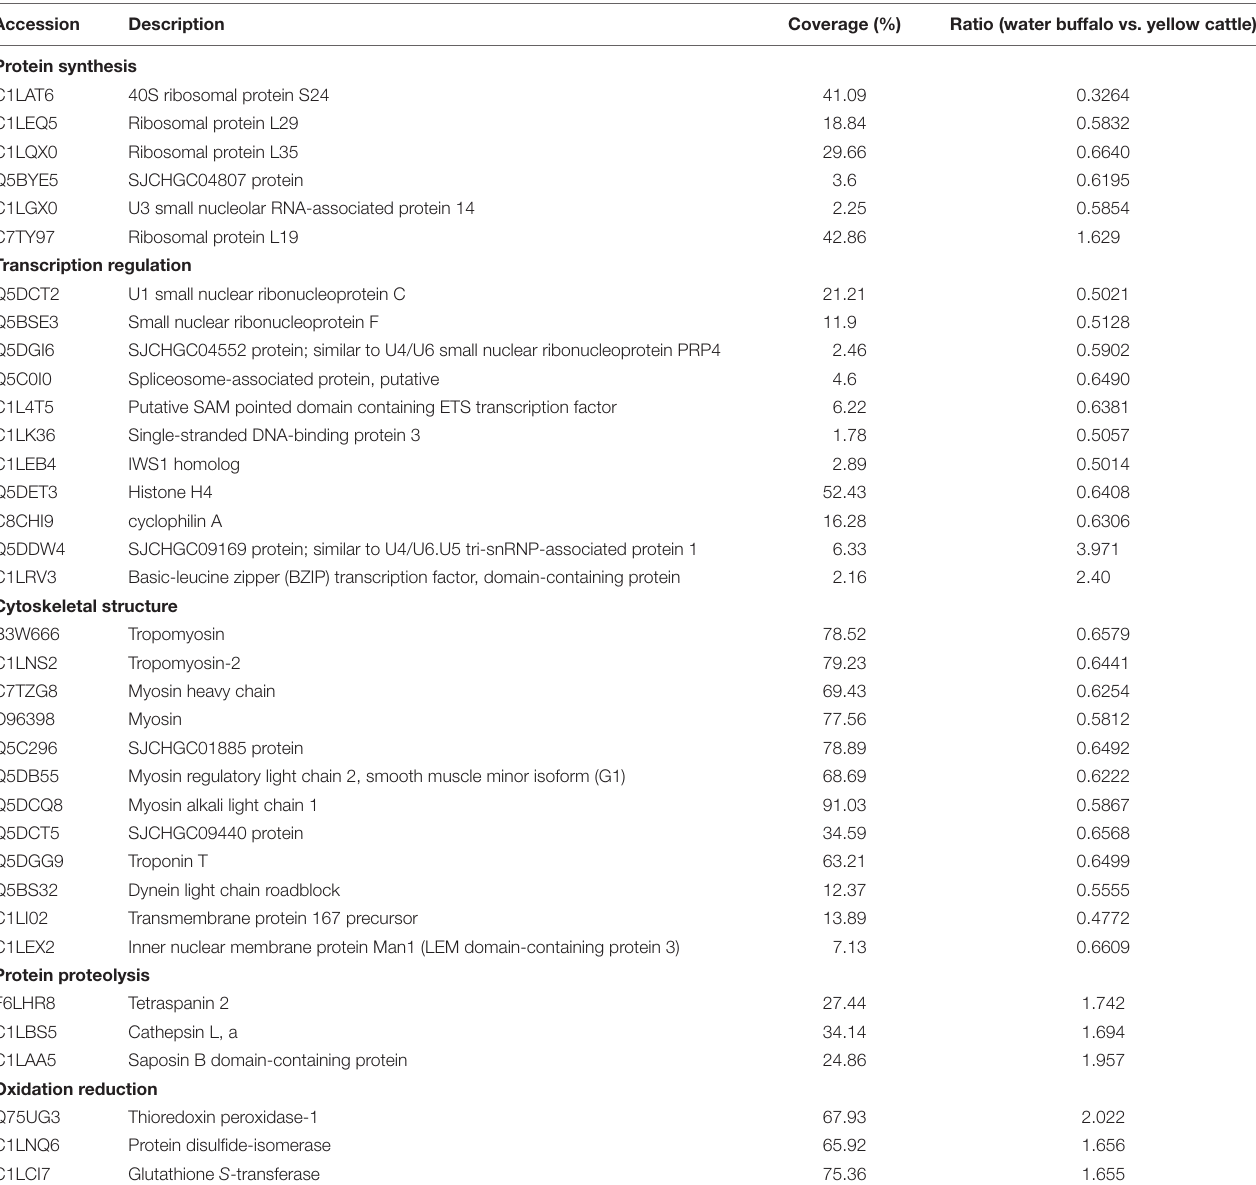
TABLE 3 | Selected DEPs of adult Schistosoma japonicum worms from water buffalo and yellow